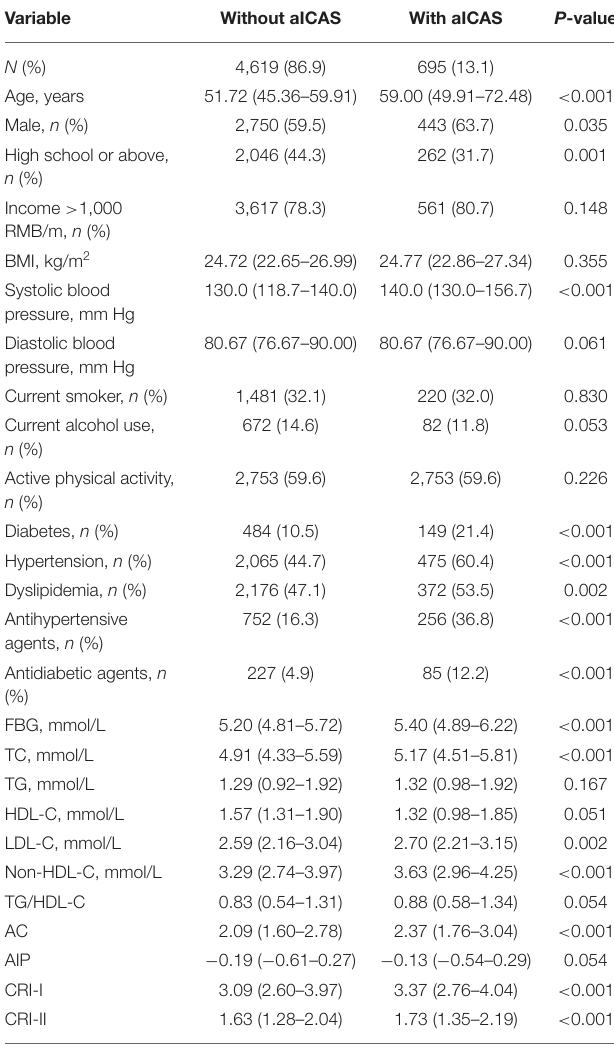
TABLE 1 | Clinical characteristics between groups with/without